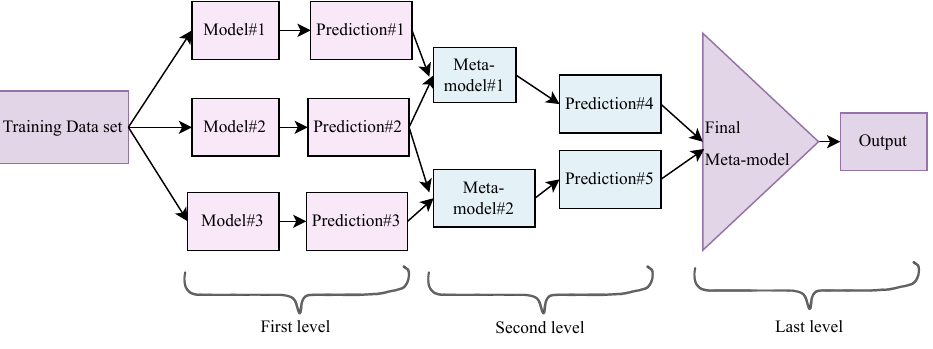
Figure 8. The proposed multi-stacking EL